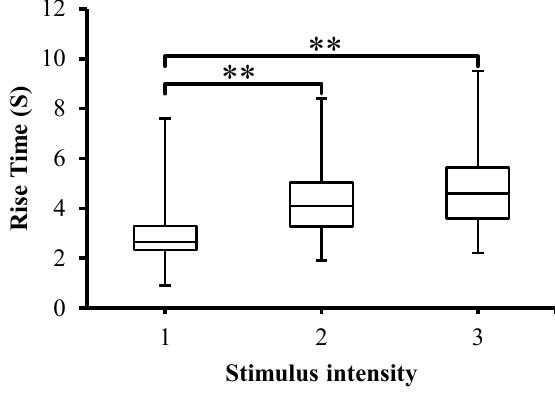
Fig. 8: SCR_Trise to the different stimulus intensity presented as box- plots with medians, quartiles and the min and max as whiskers. ** p